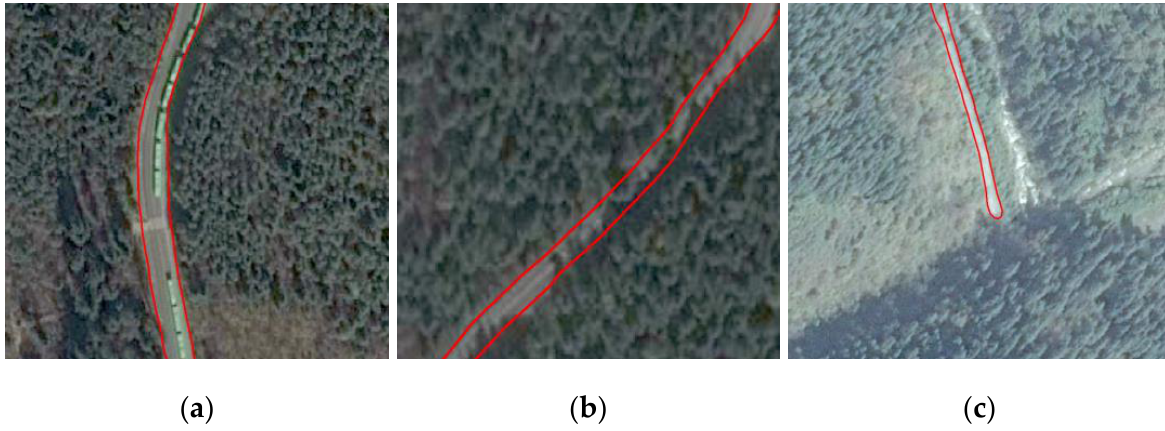
Figure 13. Typical details of road extraction using our proposed model: ( a ) Extraction result of road with vehicles; ( b ) extraction result of road with tree shadow; ( c ) extraction result of road in the area with tall trees.